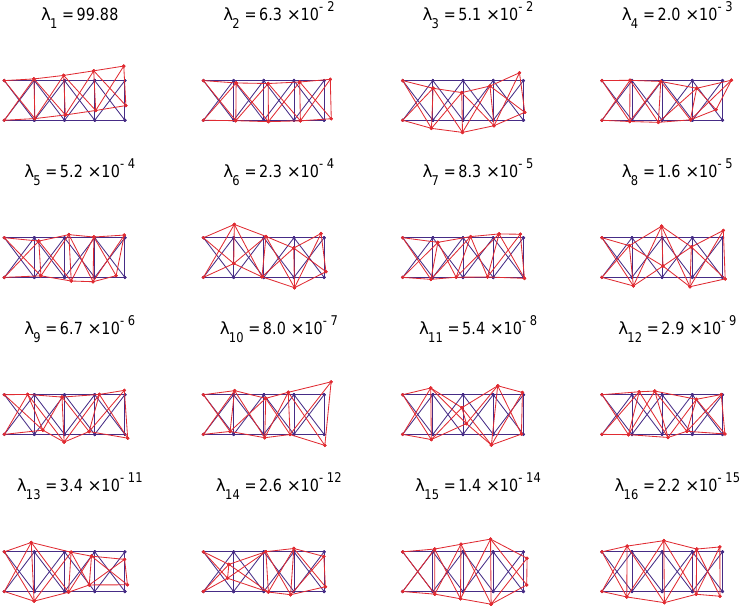
Fig. 8. Proper orthogonal modes with respective mean energies for an impulsive force applied at node 10 in both directions and with damping being considered. A more straightforward strategy for finding the